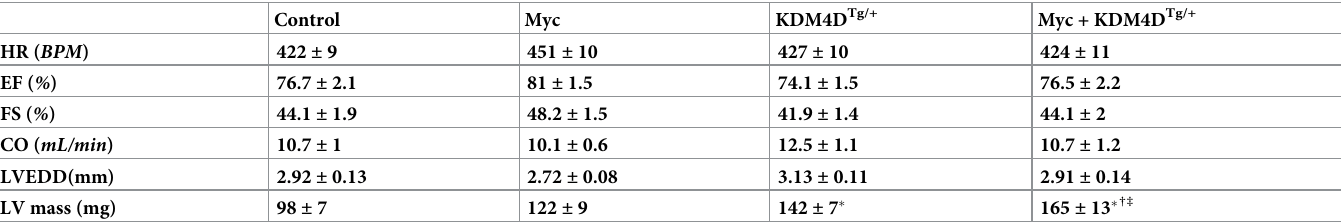
Table 1. Cardiac function in MycER+KDM4D Tg/+ triple-transgenic mice.